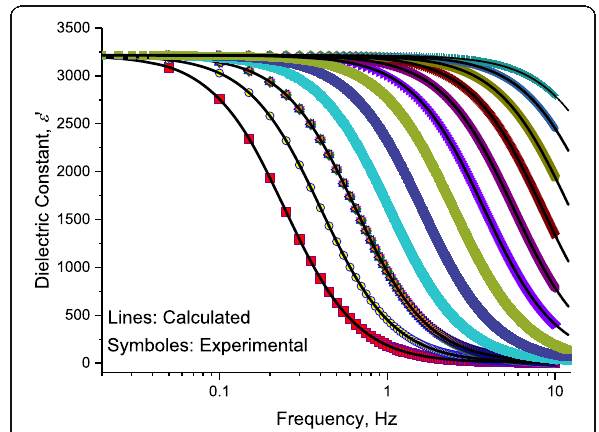
Fig. 21 At low frequency range, for H1: dielectric constant dielectric constant, ε ’ measured as a function of frequency at different temperatures. Symbols represent experimental values, and lines represent calculated values after Eq. (11); for the temperatures 288, 293, 298, 303, 303, 308, 313, 318, 323, 328, 333, 338, and 343 K, where red rectangles represent values of ε ’ at 288 K, and yellow circles represent value of ε ’ at 293 K,